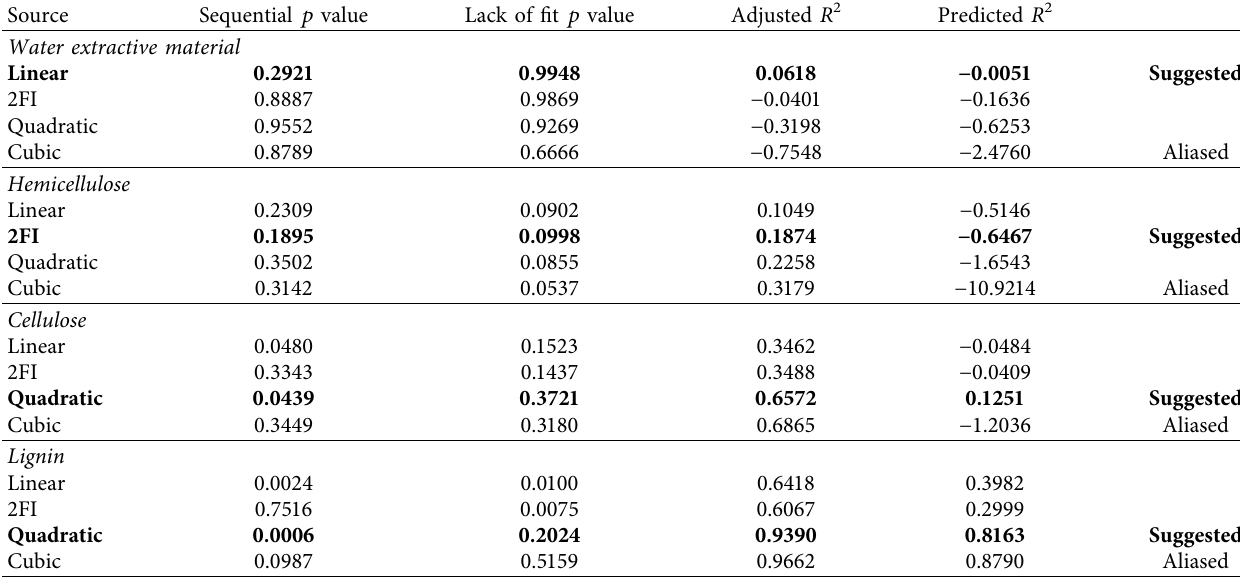
Table 4: Fit summary.